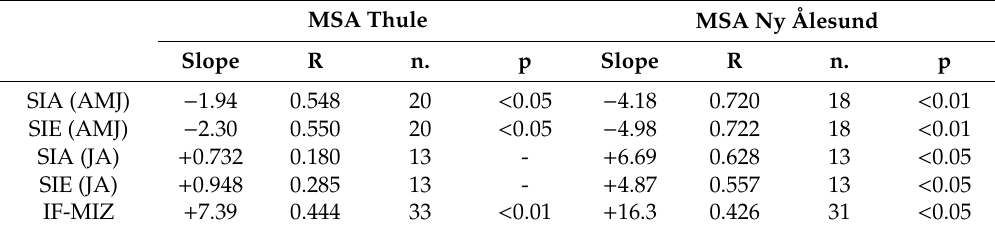
Table 2. Correlation parameters and significance of correlations between monthly mean MSA (at Ny Ålesund and Thule) and the two factors sea ice area (SIA) and sea ice extent (SIE). Two time periods are considered: April, May, and June (AMJ), and July and August (JA). The correlation between MSA and the ice-free area in the marginal ice zone (IF-MIZ) is also indicated but for the April–August time period. MSA Thule MSA Ny Ålesund Slope R n. p Slope R n. p SIA (AMJ) − 1.94 0.548 20 < 0.05 − 4.18 0.720 18 < 0.01 SIE (AMJ) − 2.30 0.550 20 < 0.05 − 4.98 0.722 18 < 0.01 SIA (JA) + 0.732 0.180 13 - + 6.69 0.628 13 < 0.05 SIE (JA) + 0.948 0.285 13 - + 4.87 0.557 13 < 0.05 IF-MIZ + 7.39 0.444 33 < 0.01 + 16.3 0.426 31 <